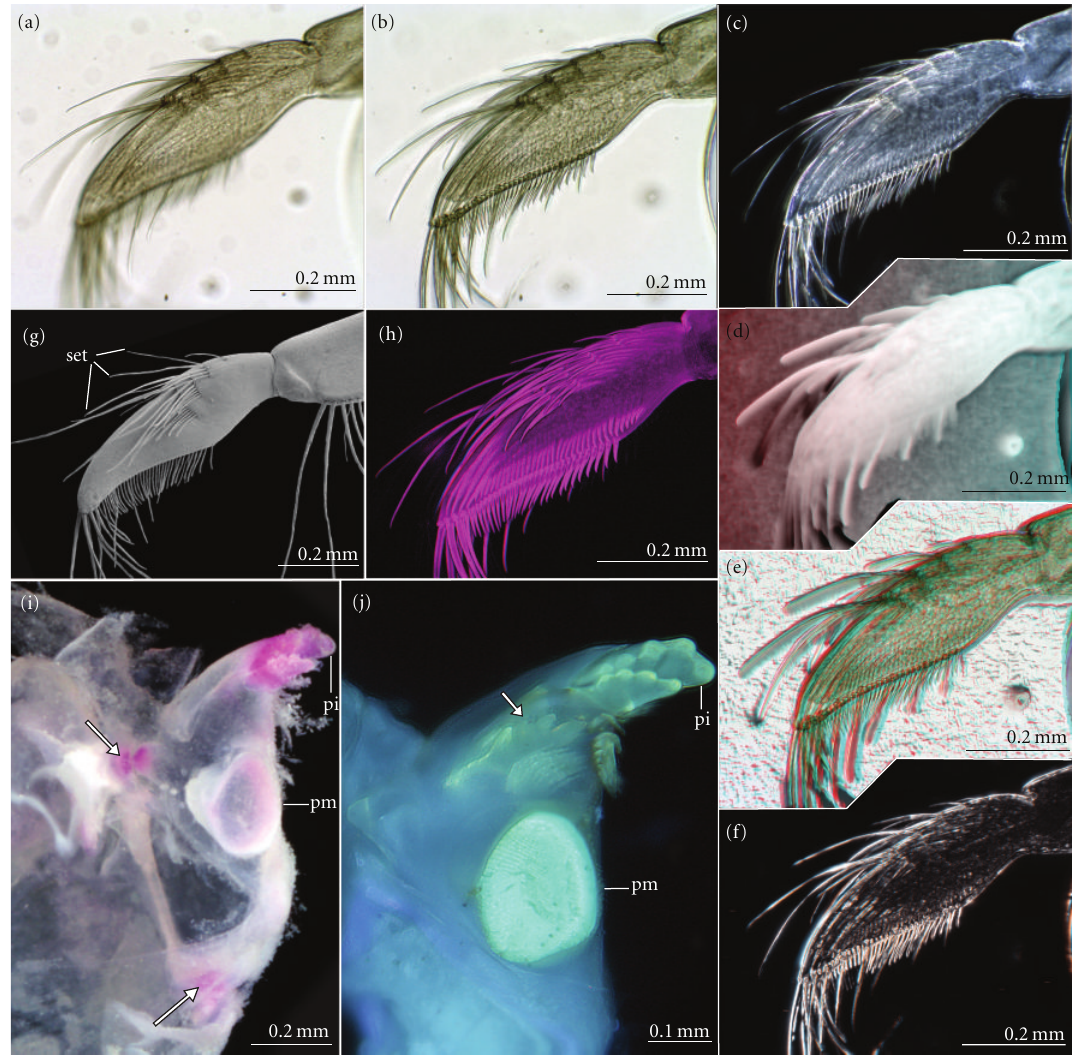
Figure 4: Di ff erent microscopical methods applied to structures of the mandible of Dikerogammarus haemobaphes . (a)–(h) Tip of the mandibular palp ((a)–(f) and (h) depict the same specimen). Red-cyan glasses needed to experience the stereo e ff ect in (d)–(f) and (h). (a) A single focal plane of a bright field frame. Note the limited depth of field and the resulting blurring. (b) Fused image based on a stack of 20 frames of di ff erent focal planes, including also the frame from (a). (c) Fused image of a stack of 27 dark field frames. (d) Red-cyan stereo anaglyph of a surface model based on stack used for image (b). (e). (b) rendered onto (d). (f) Red-cyan stereo anaglyph based on the stack used for (c), following the procedure of Haug et al. [15]. (g) SEM micrograph of a comparable specimen. (h) Same specimen as in (a)–(f). Red-cyan stereo anaglyph based on an autofluorescence image from an inverted microscope with a spinning disc. The spinning disc suppresses scattered light. Due to the inversion, the other side of the palp is visible (note that the setae seem to come out of the image instead of reaching into it). Image flipped horizontally to enhance comparability. (i) Sagittal cut of the left part of the cephalothorax with left mandible, alizarin staining. Arrows point to the pivots of the joint. (j) Autofluorescence micrograph of a right mandible in median view. Arrow points to new pars incisiva underneath the current cuticle. Abbreviations: set: setae, pi: pars incisiva, pm: pars molaris.